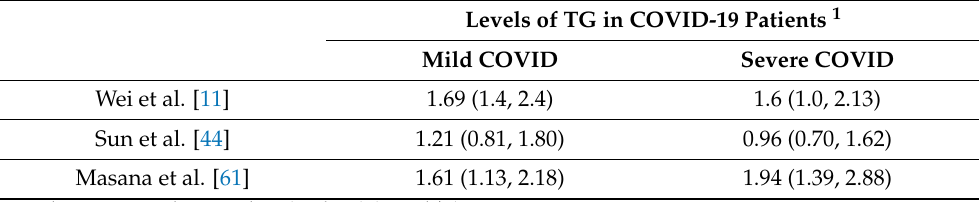
Table 3. Level of triglycerides in COVID-19 patients in relation to the severity of the